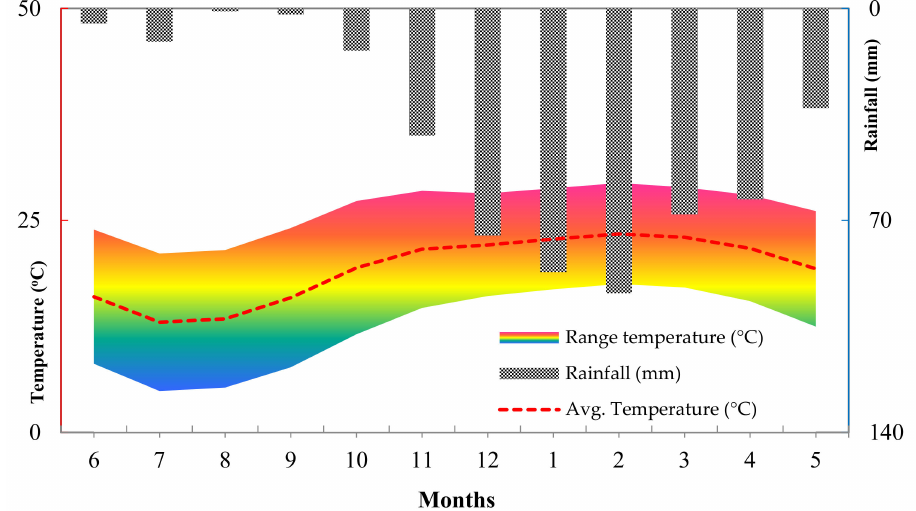
Figure 2. Monthly average rainfall and temperature pattern of the study area